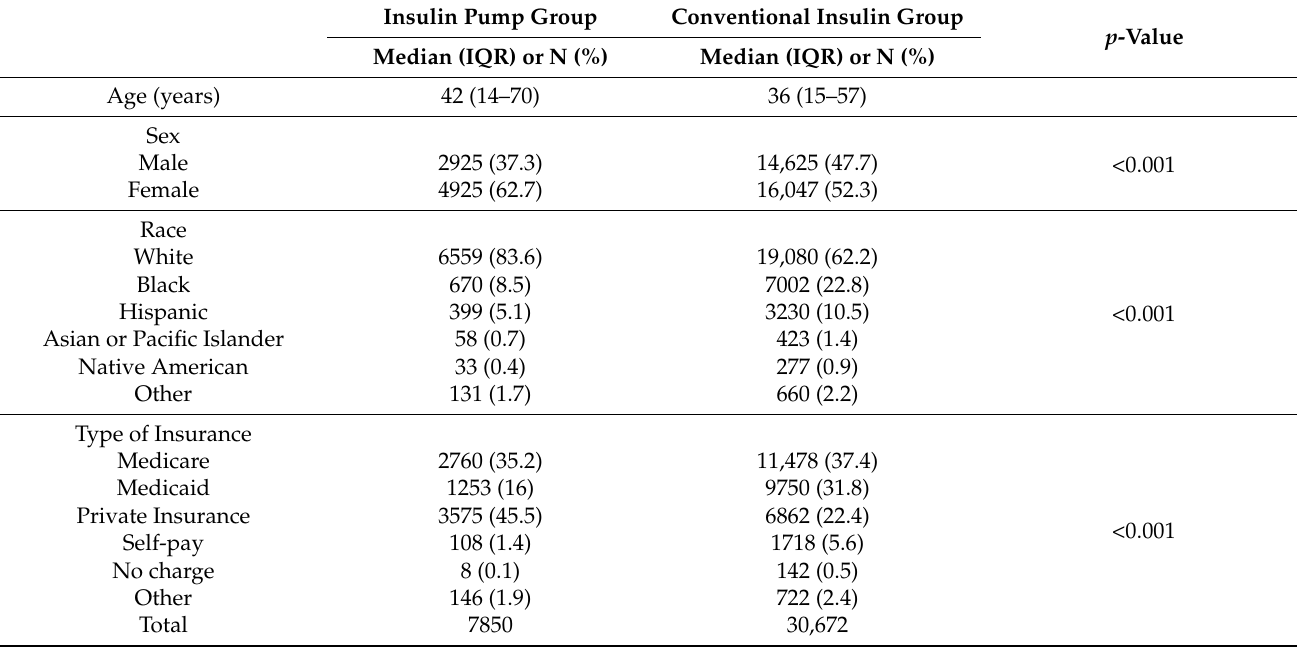
Table 1. Comparison of Baseline Characteristics of Insulin Pump Group and Conventional Insulin Group before Matching. Insulin Pump Group